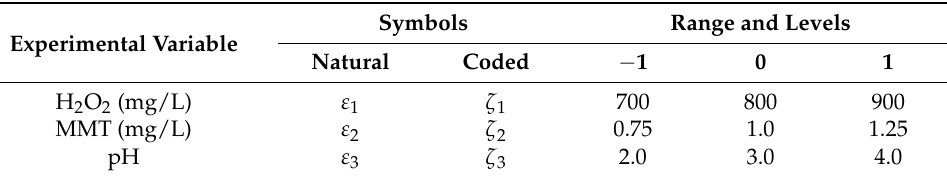
Table 2. Boundaries of model design for the coded and natural experimental domains and the corresponding levels’ spacing.